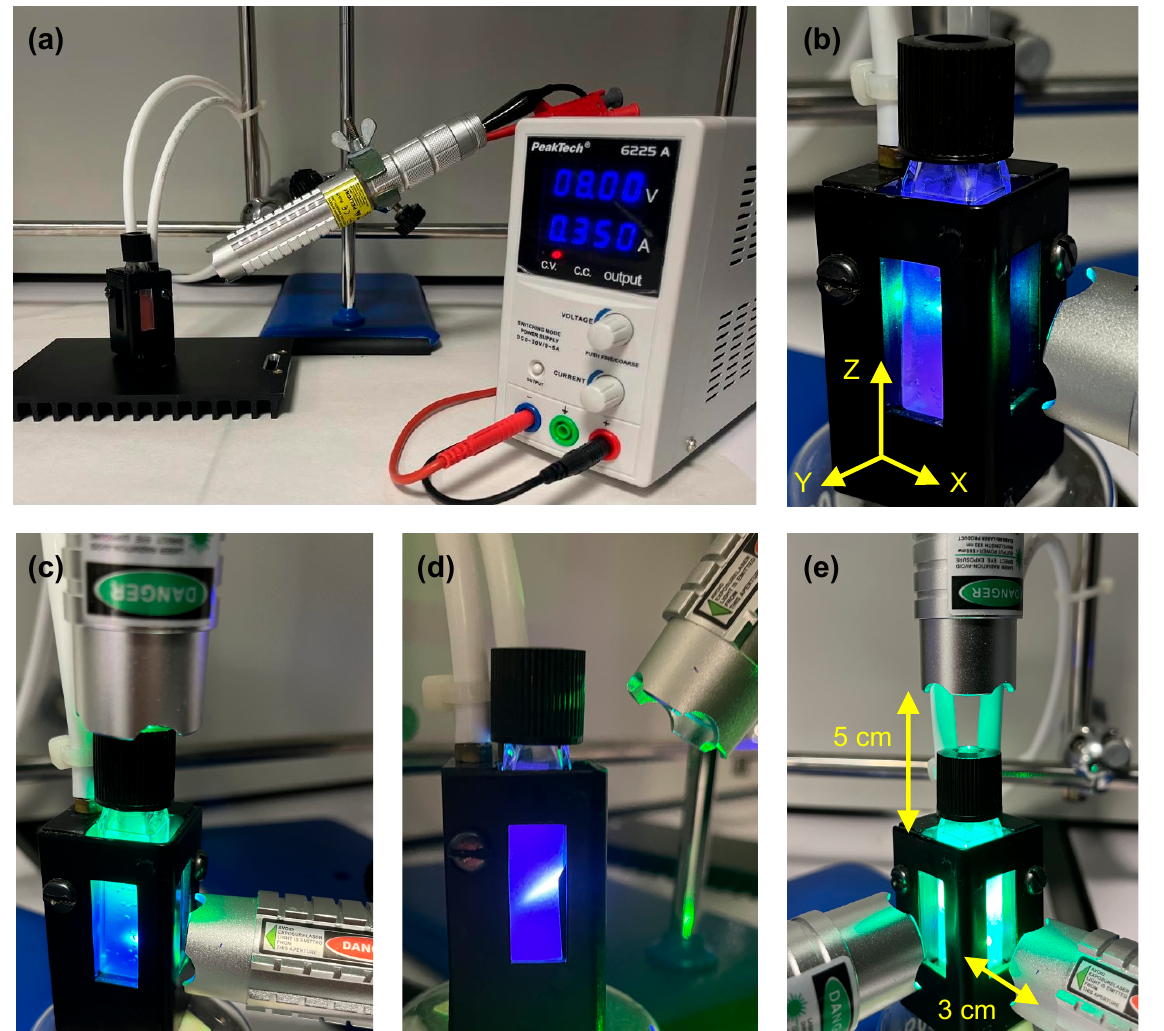
Figure 2. ( a ) Irradiation set-up used in this work for the intragel photoreduction of aryl halides by TTA-UC using low-cost laser pointers. Representative pictures of green-to-blue upconversion under aerobic conditions achieved with: ( b ) 1 laser pointer aligned to X -axis; ( c ) 2 perpendicular laser pointers; ( d ) 1 laser pointer with light incidence adjusted at 45°; and ( e ) 3 laser pointers aligned to the xyz-coordinated axes. General reaction conditions: [ 1 ] = 10 mM, [ PtOEP ] = 33 μ M, [ DPA ] = 6.7 mM, [ G-1 ] = 10 g/L, λ exc = 532 nm, DMF = 3 mL.